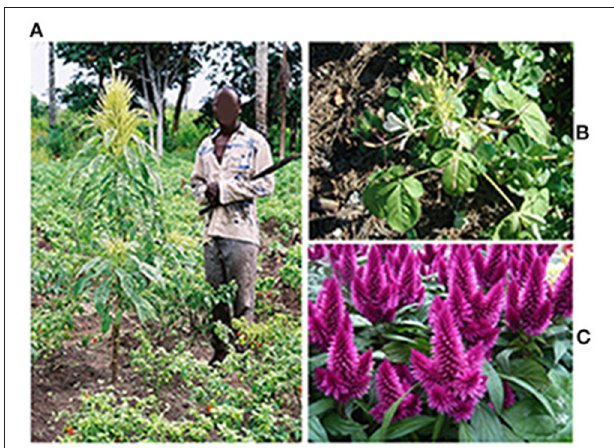
FIGURE 9 | African ‘Leafy Greens’. (A) Amaranth (Amaranthus cruentu). Source: Scamperdale. CC BY-NC-SA 2.0. (B) Spider plant (Cleome gynandra). Source: F. Starr and K. Starr. CC BY 2.0. (C) Celosia (Celosia sp.). Source: B. Pettinger. CC BY-NC-SA